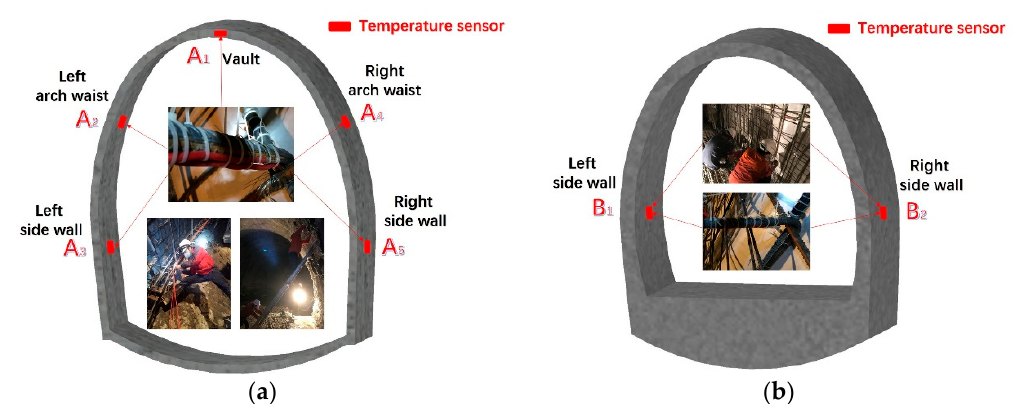
Figure 6. A cross-section of the tunnel.